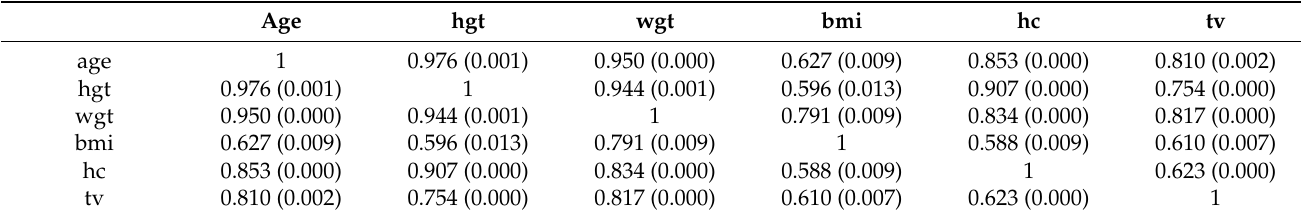
Table 3. Bivariate correlations of the numerical columns in the true data with in parentheses the corresponding bias of the m = 5 pooled synthetic correlations over 1000 simulations. All estimates are rounded to 3 decimal places.